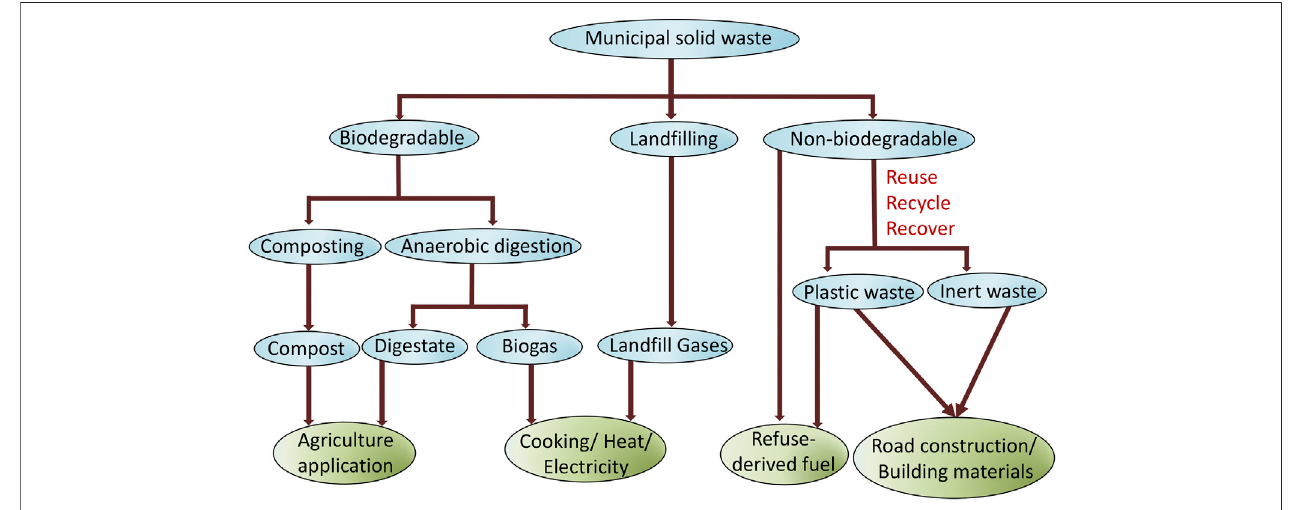
FIGURE 4 | Overview of resource recovery from MSW. MSW is segregated into biodegradable and non-biodegradable waste. Biodegradable waste undergoes composting process and produces organic fertilizer, whereas anaerobic digestion ends up with the production of biogas and undigested material (digestate). Both fertilizeranddigestateposepotentialapplicationsinthe fi eldofagriculture.Theenergyproducedintheformofbiogascanbeusedforcookingpurposesandtogenerate electricity. The non-biodegradable waste such as plastic and inert waste can be recycled and reused into materials that can be used to construct roads, buildings, and RDF. The unprocessed or untreated waste is targeted to land fi lling that can produce land fi ll gas, which helps in electricity